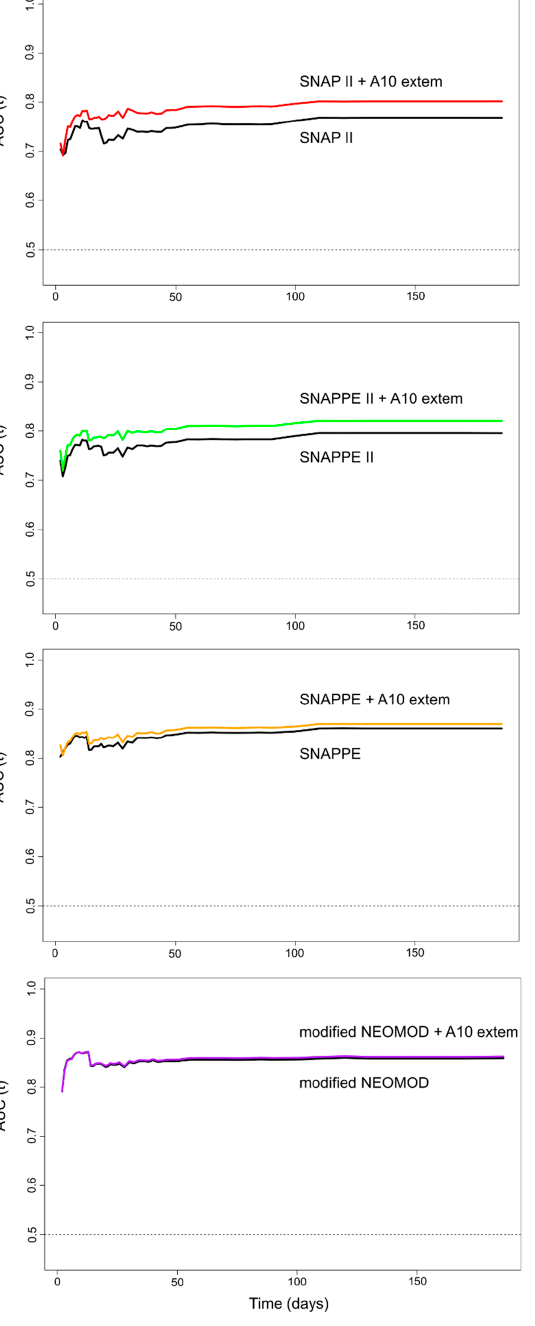
Figure 6. Over time prognostic performance of the scores in predicting death after the addition of A10. Red line, SNAP II + A10 extem; black line, SNAP II; green line, SNAPPE II + A10 extem; yellow line, SNAPPE + A10 extem; purple line, modified NEOMOD + A10 extem; the dotted line (of AUC = 0.5) means the model has no discrimination